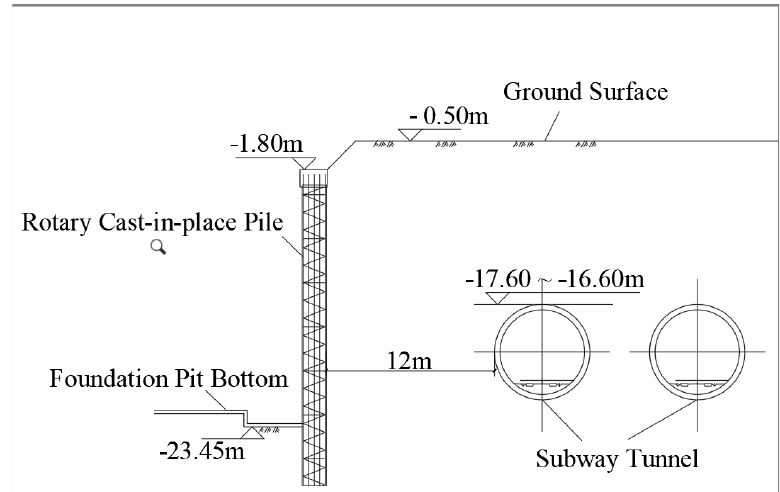
Figure 2. Schematic diagram of the typical cross-section of foundation pit.